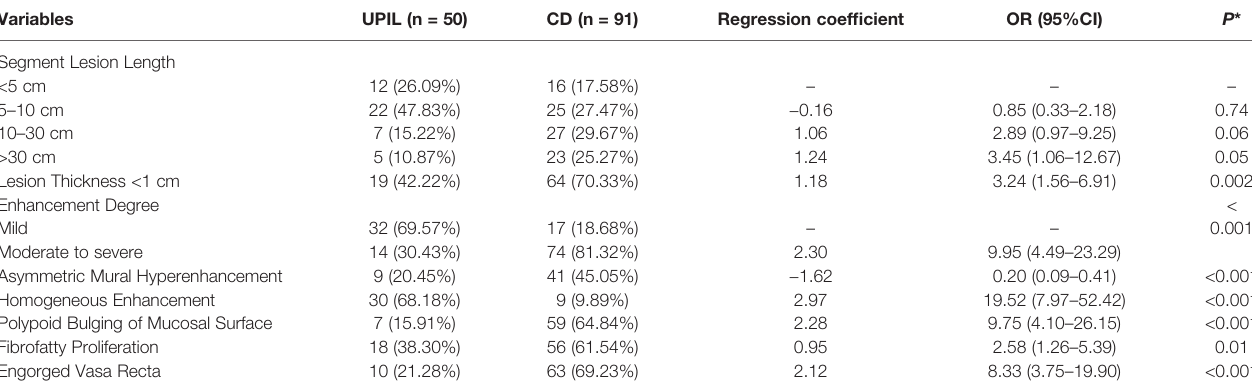
TABLE 5 | Imaging Characteristics of Participants with Crohn ’ s disease or Ulcerative Primary Intestinal Lymphoma.